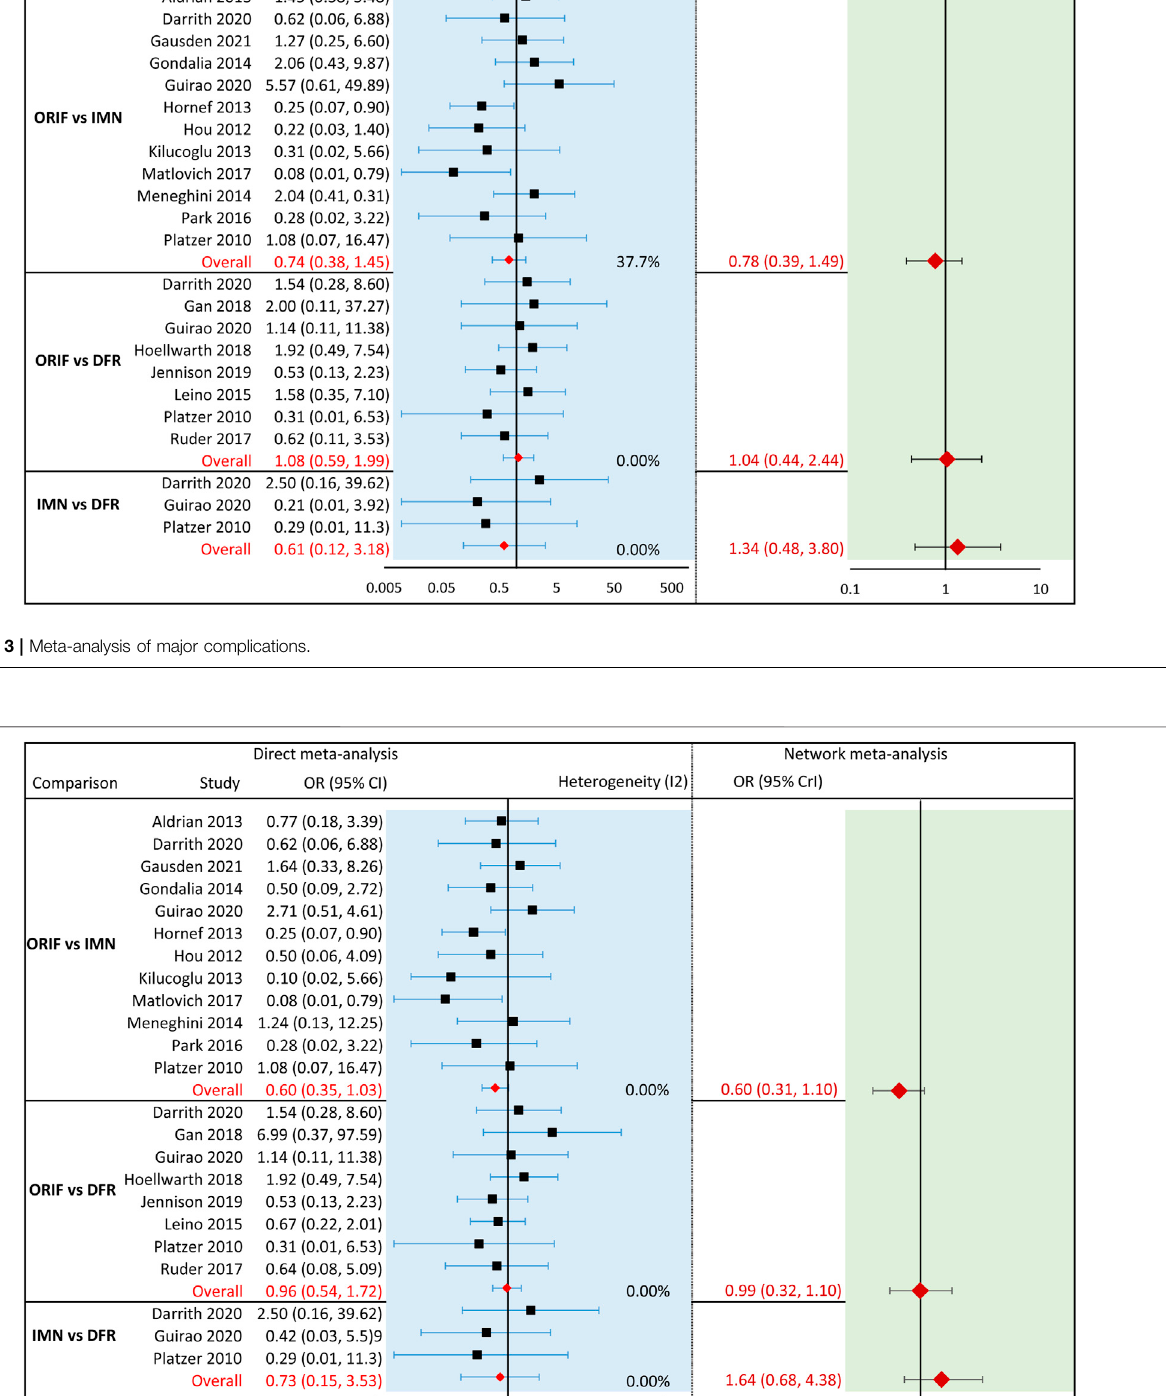
Frontiers in Materials |